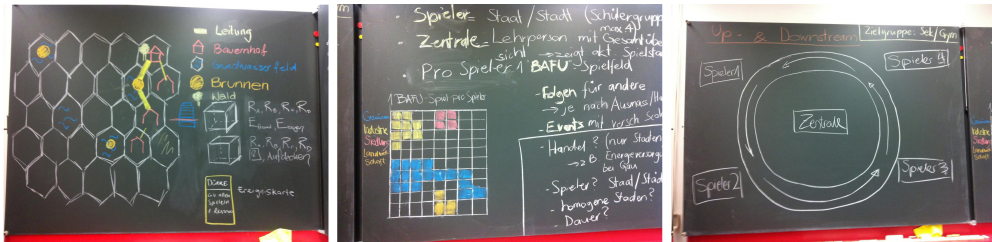
Figure 4. Initial stages of game development with idea boards. Board 1 (left) shows a hypothetical game board with options for introducing a pipeline (Leitung), farmyard (Bauernhof), groundwater source (Grundwasser Feld), well (Brunnen), forest (Wald), and drought (Dürre) – > event card (Ereigniskarte). Board 2 (middle): game board development based on the FOEN, 2015 game. Board 3 (right): hypothetical game idea for a computer game based on the idea of upstream downstream river use and influence on each player